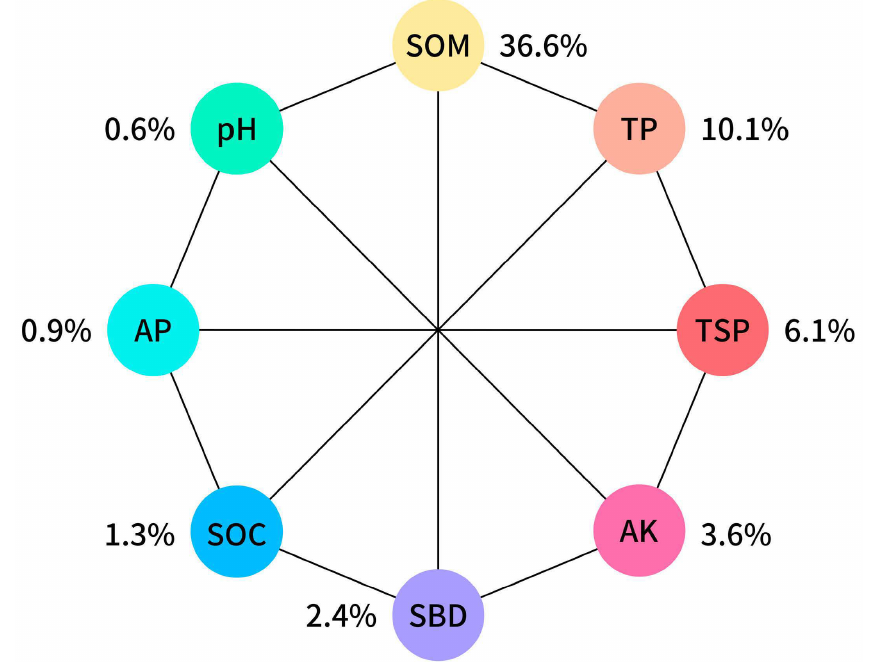
Figure 8. Variance partitioning analysis (VPA) showing the effects of soil factors on understory plant diversity in spring and